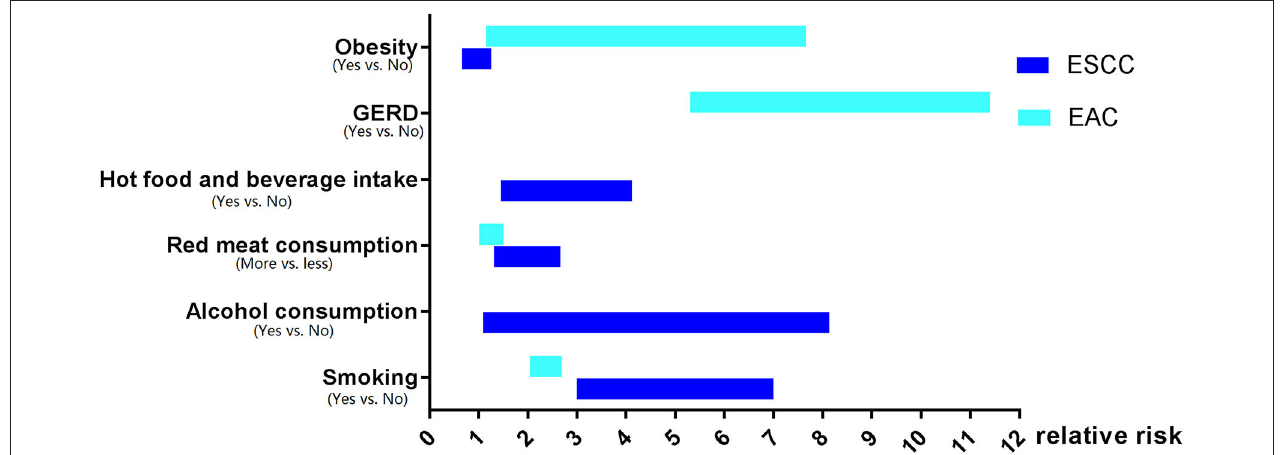
FIGURE 1 | The risk factors profiles for esophageal squamous cell carcinoma and esophageal adenocarcinoma.